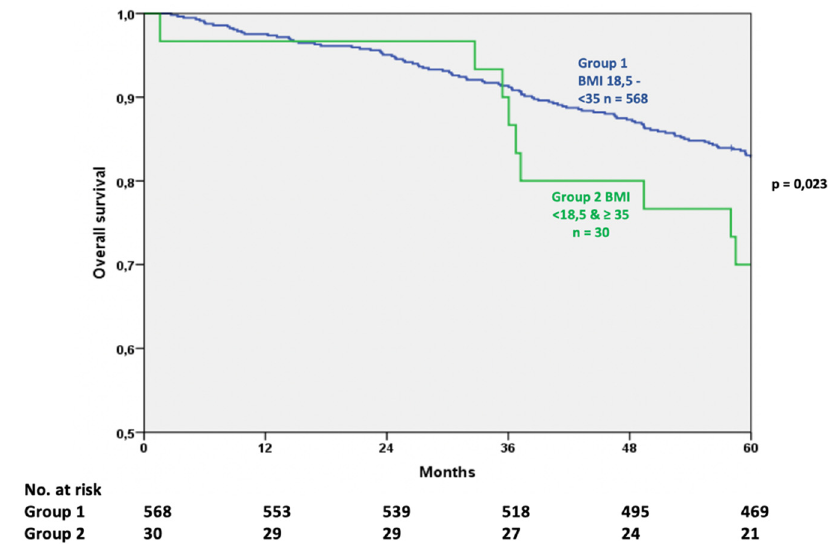
Figure 2. Comparison of overall survival after oncological treatment (log rank test).